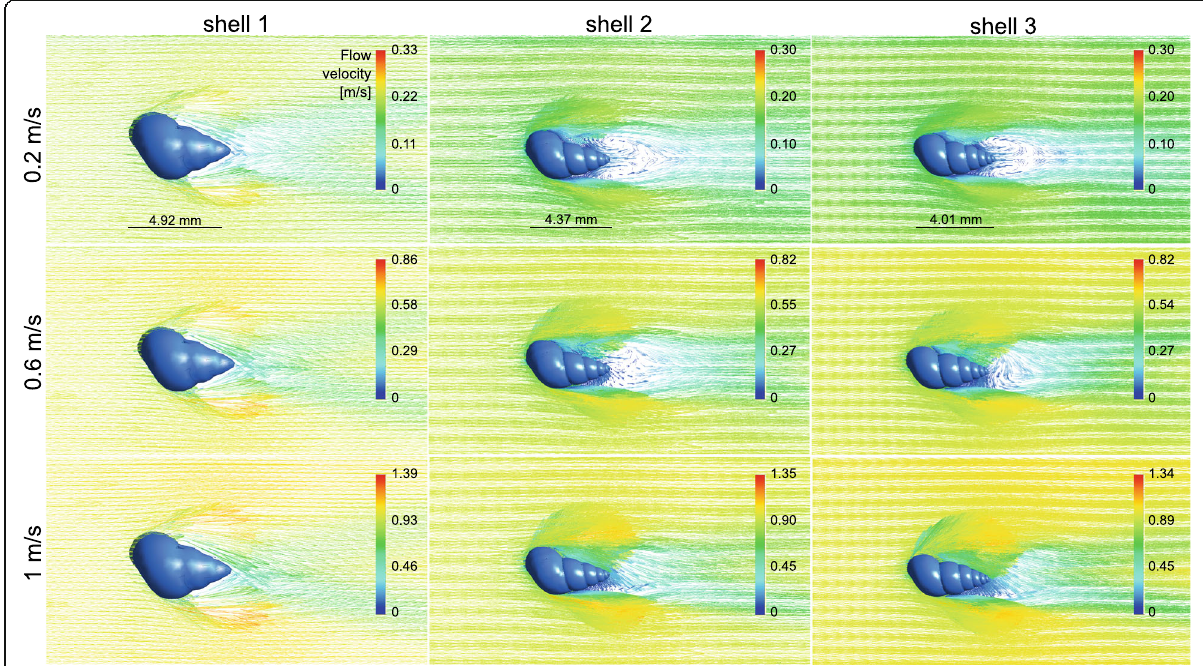
Fig. 6 Top view of the flow environment around the STL shell models 1 – 3 at three different flow velocities. Original flow direction in the channel from left to